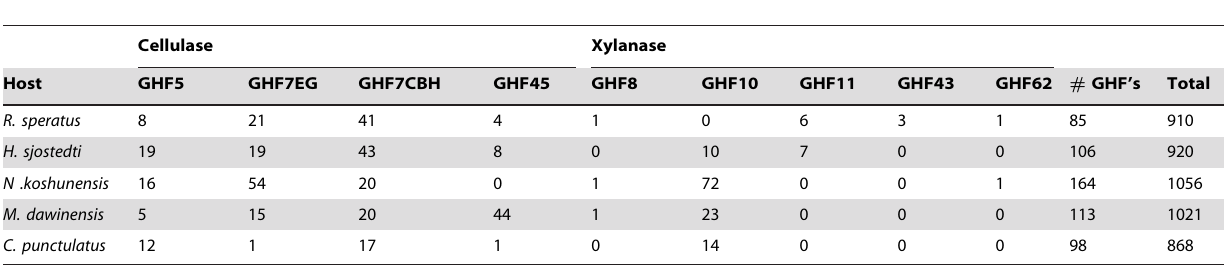
Table 1. The number of GHF clones from EST analysis.